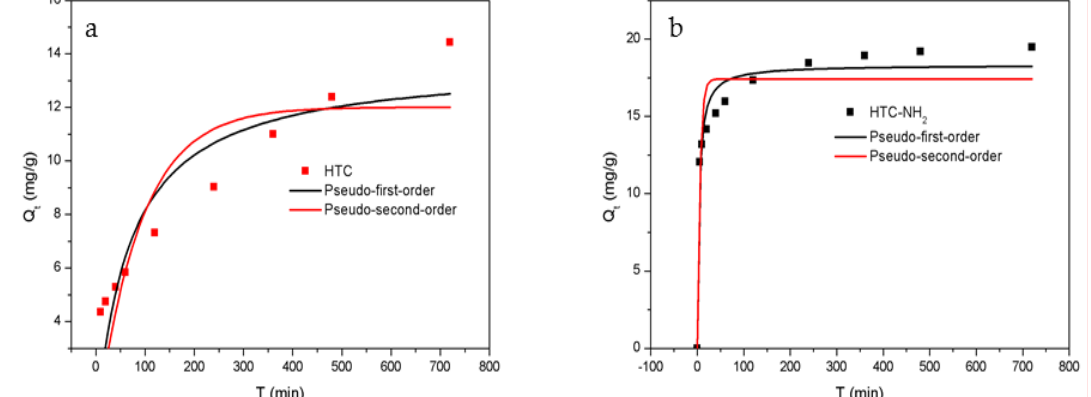
Figure 7. Adsorption kinetics of Cr(VI) onto samples: ( a ) HTC and ( b ) HTC-NH 2 .